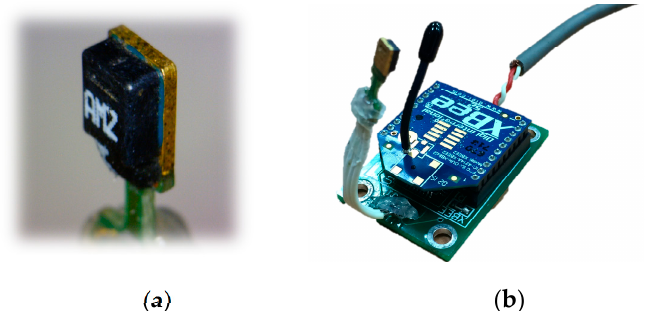
Figure 1. RH/T microsensor developed in this study. ( a ) SHT-series (1×/7×); ( b ) XBee series 2.